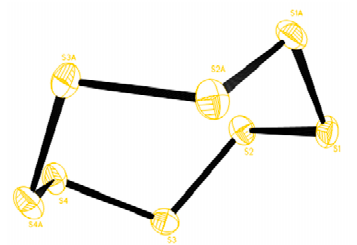
Figure 3. X-ray representation of cyclooctasulfur.